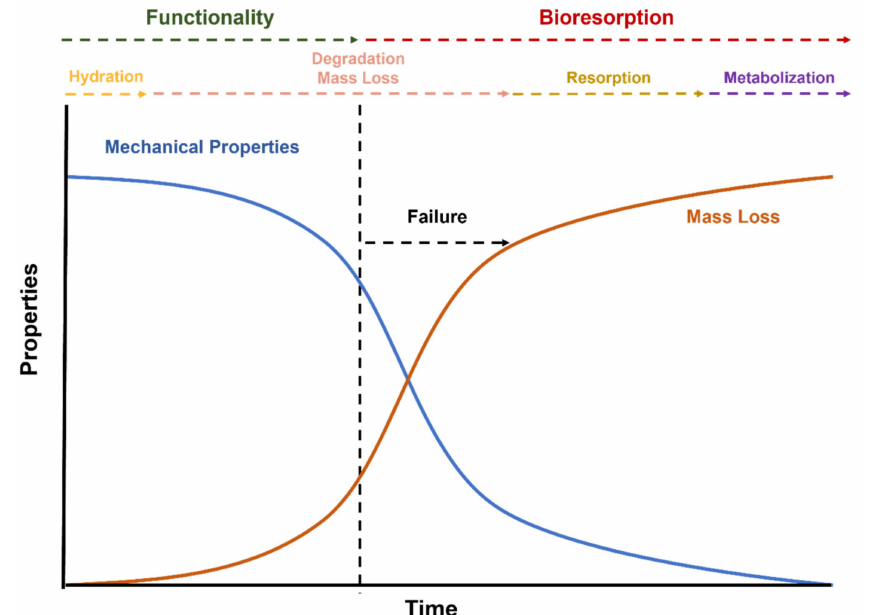
Figure 3. Relationship between polymer properties and degradation of postimplanted BRSs.